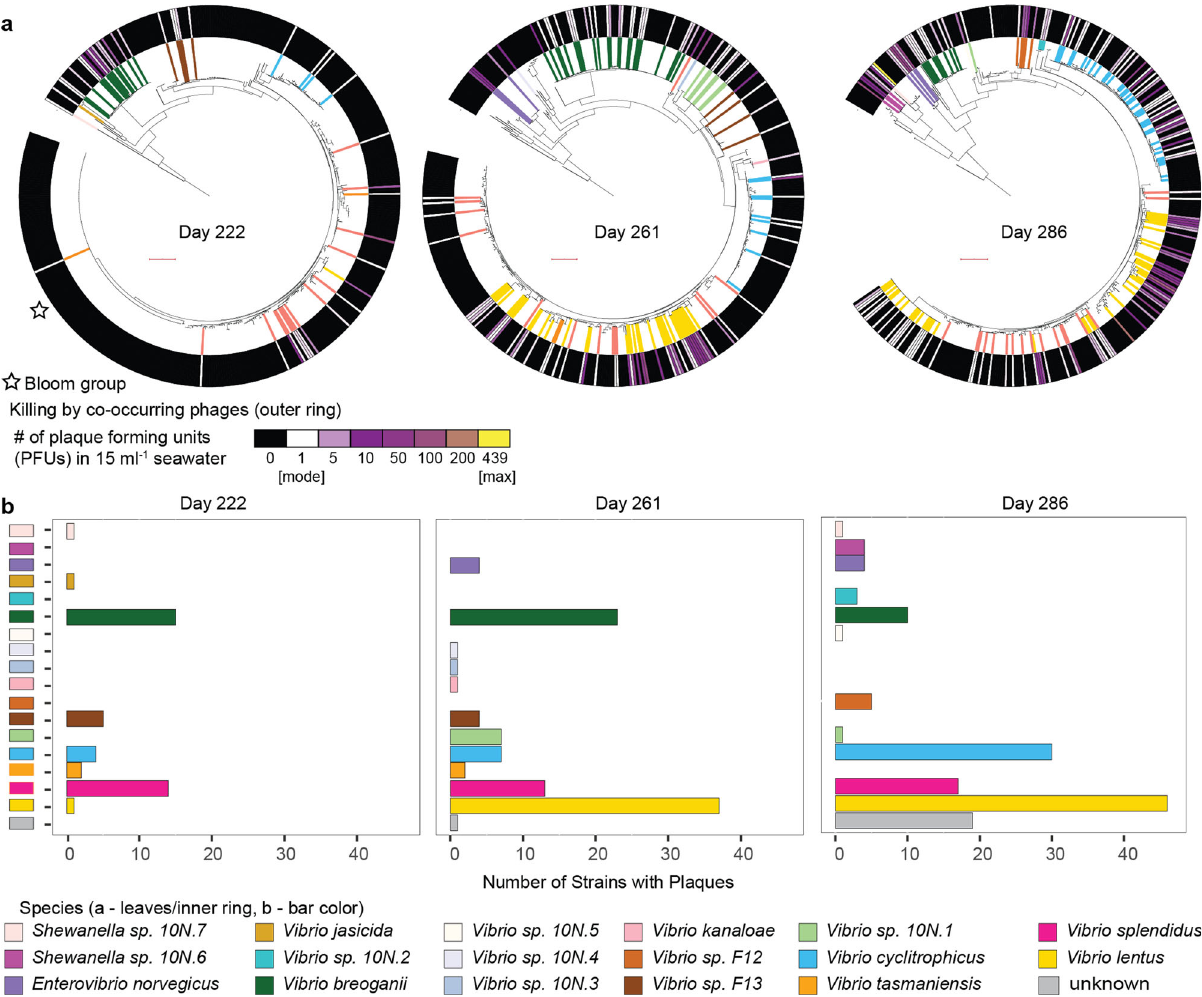
Fig. 1 Phage predation pressure on individual bacterial strains appears low overall, is not uniform among closely related bacterial isolates, and varies across days of sampling. a Phylogenetic relationships between Vibrionaceae strains isolated on each of three days and screened for sensitivity to phages in seawater concentrates from the same days (449 bacterial isolates on ordinal day 222; 443 on day 261; 395 on day 286; shown as hsp60 gene trees with leaves colored by host species for isolates with sequenced genomes). Sensitivity to phage killing is shown in the outer ring, with colors representing the number of plaques formed on each strain. The majority of bacterial isolates screened had phage predator loads below the limit of detection (1 plaque forming phage unit (PFU) 15 ml − 1 concentrated seawater); with maximum plaques per strain of 90 PFU ml − 1 on day 222; 81 on day 261; 439 on day 286. We note that recovery ef fi ciencies of viruses in iron fl occulates resuspended in oxalate solution were not tested for individual samples but have been shown to be approximately 50% 14 and thus observed PFUs are conservative estimates. Though 28% (125/449) of bacterial isolates on day 222 were Vibrio tasmaniensis strains of a single hsp60 type, only a single isolate with this type was killed by co-occurring phages (10 N.222.48.A2, labeled with a star as a “ bloom group ” ), and no isolates with this hsp60 type were subsequently isolated. Tree scale of 0.1 substitutions per site indicated by red bars. b Strains killed by co-occurring phages (43 plaque-positive on ordinal day 222; 101 on day 261; 141 on day 286) were targeted for genome sequencing and used in subsequent host range assays. Underlying data provided in Supplementary Data 1, see Methods for strain sets